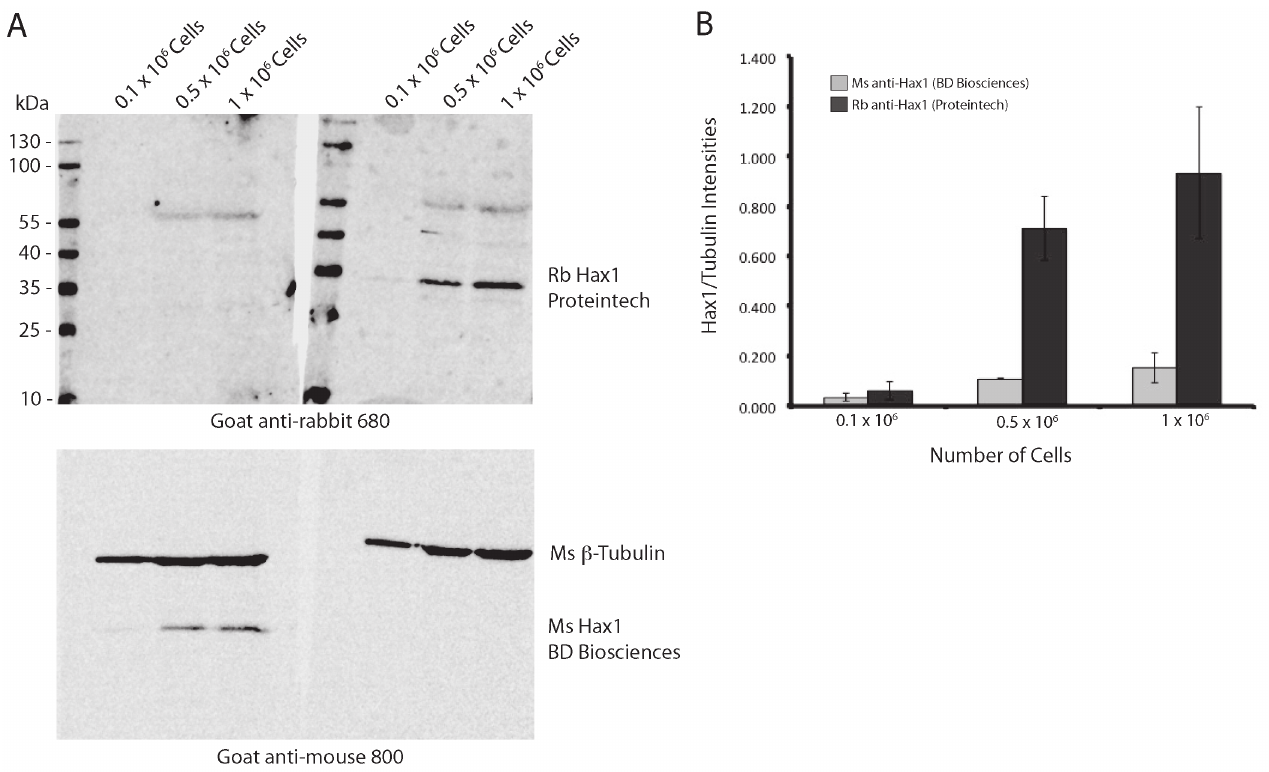
Figure 3. Comparison of mouse and rabbit anti-Hax1 antibodies in differentiated PLB-985 cells. ( A ) Western blot analysis of differentiated PLB-985 cell lysates from 0.1 × 10 6 , 0.5 × 10 6 , and 1 × 10 6 cells comparing mouse and rabbit anti-Hax1 antibodies. Lysates from the same cell extractions were run on a single SDS-PAGE gel and blotted onto a single nitrocellulose membrane. After transfer, the membrane was divided and probed with either mouse anti-Hax1 or rabbit anti-Hax1. The membranes were imaged simultaneously. ( B ) Quantification of the ratios of Hax1 and tubulin band intensities from three independent blots were measured and plotted. Error bars indicate standard deviation.